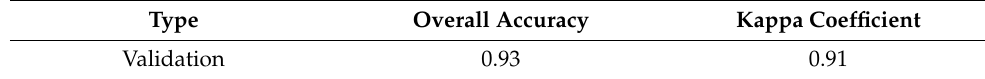
Table 2. Classification results of the study area.